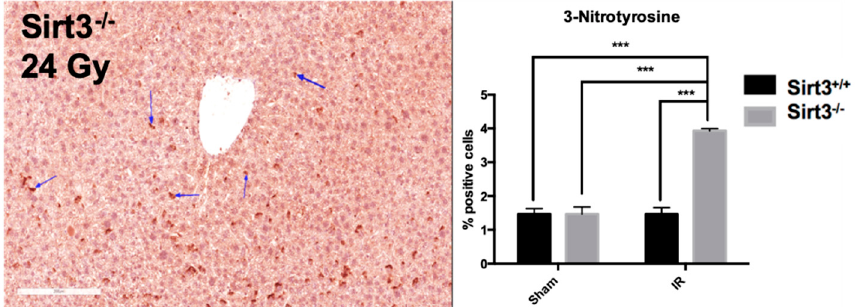
Figure 6. Protein oxidation, determined by 3-nitrotyrosine staining (indicated by the arrows), was increased in irradiated Sirt3 − / − mice compared to sham irradiated Sirt3 +/+ or Sirt3 − / − as well as Sirt3 +/+ irradiated groups. Scale bar: 200 μ m (15 fields scored per mouse, n = 4–6; *** p < 0.001 ).